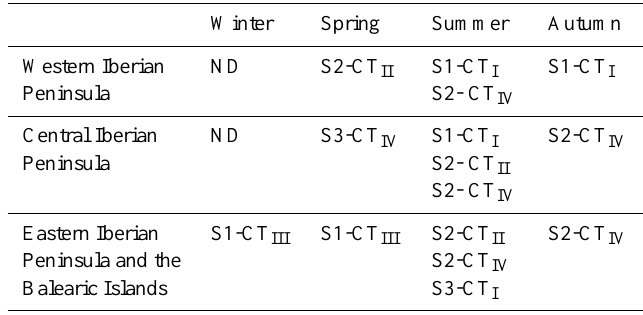
Table 4. Greatest potential source areas of African dust obtained for the western, central and eastern regions of the study area, for each circulation type (CT i ) and season (S1: Western Saharan and Morocco; S2: Algeria; S3: northeastern Algeria and Tunisia).